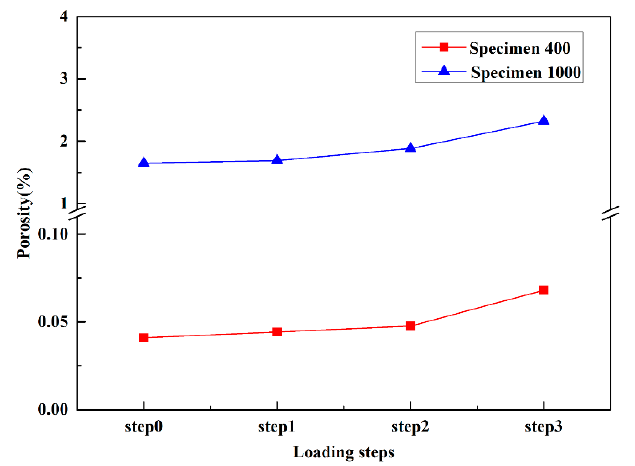
Figure 4. Porosity evolution of Specimen 400 and Specimen 1000 at di ff erent loading steps.